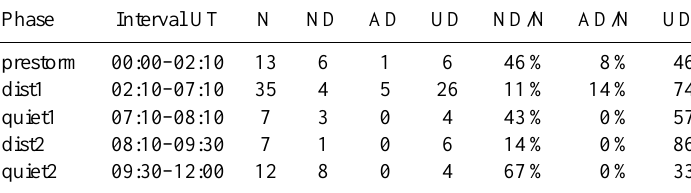
Table 3. The same as Table 2 but storm phases are defined according to the AL index.